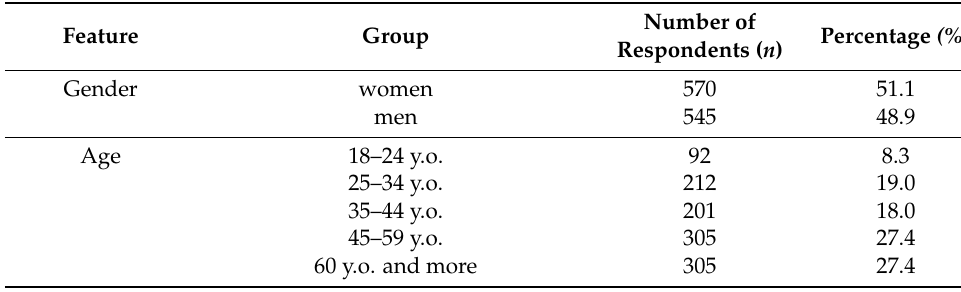
Table 1. Socio-demographic characteristics of the respondents.